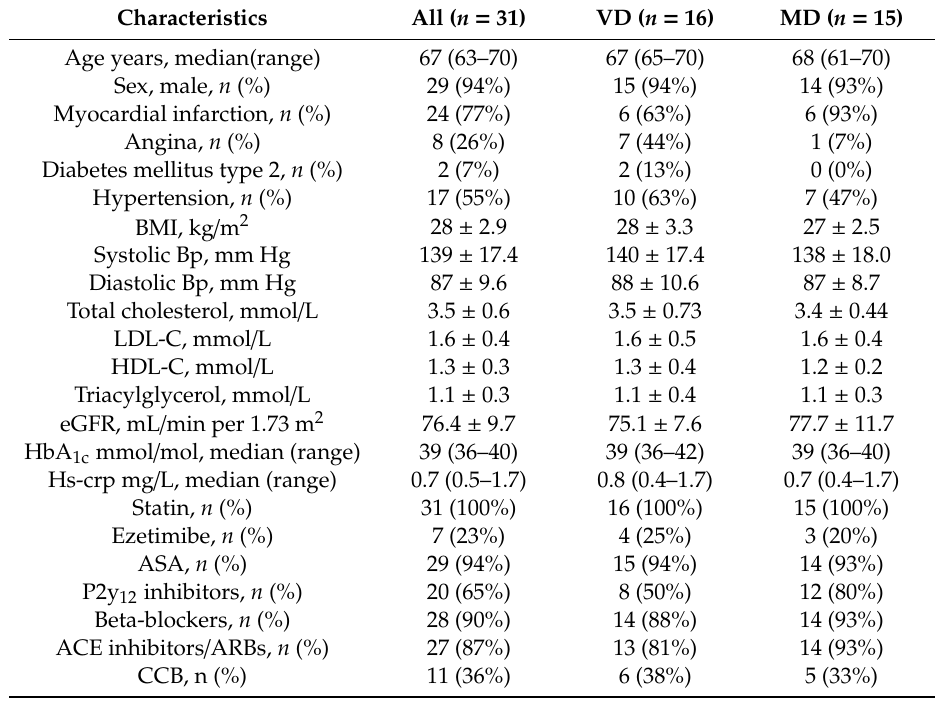
Table 1. Baseline characteristics of VERDI study